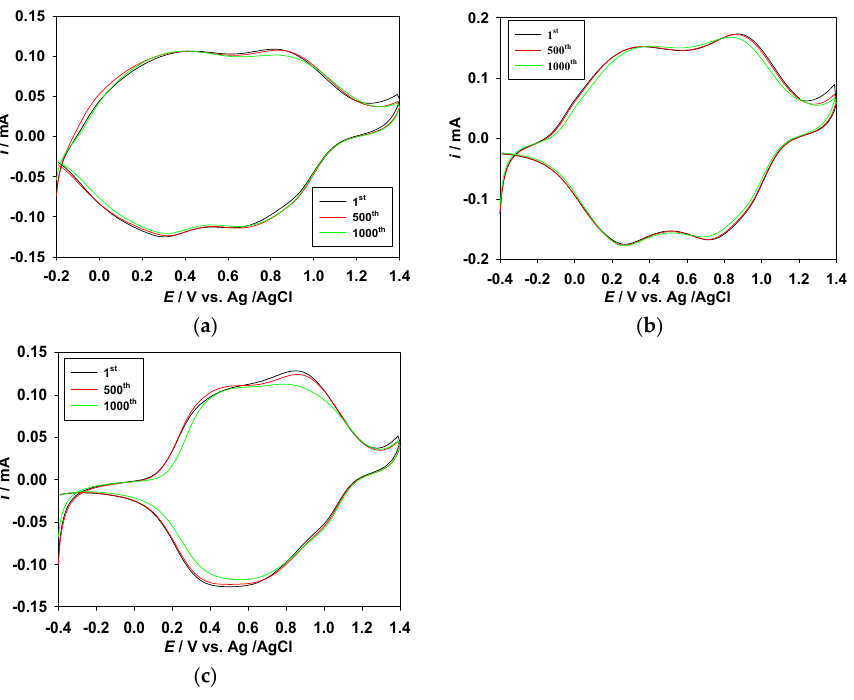
Figure 10. Cyclic voltammograms of ( a ) PMPS/PProDOT-Et 2 ; ( b ) PMPO/PProDOT-Et 2 , and ( c ) PANIL/PProDOT-Et 2 ECDs as a function of repeated scans at 100 mV·s − 1 .